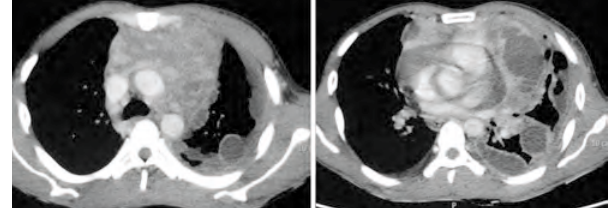
Fig. 4. (A) Chest radiograph showing an anterior mediastinal mass silhouetting the ascending aorta. (B) Axial CT image showing solid anterior mediastinal mass (arrow) with direct invasion of the superior vena cava (arrowhead) in a case of invasive